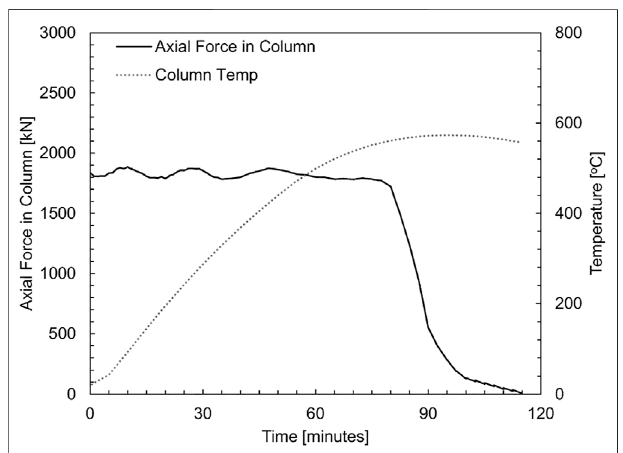
FIGURE 6 | Axial load history and temperature history for gravity